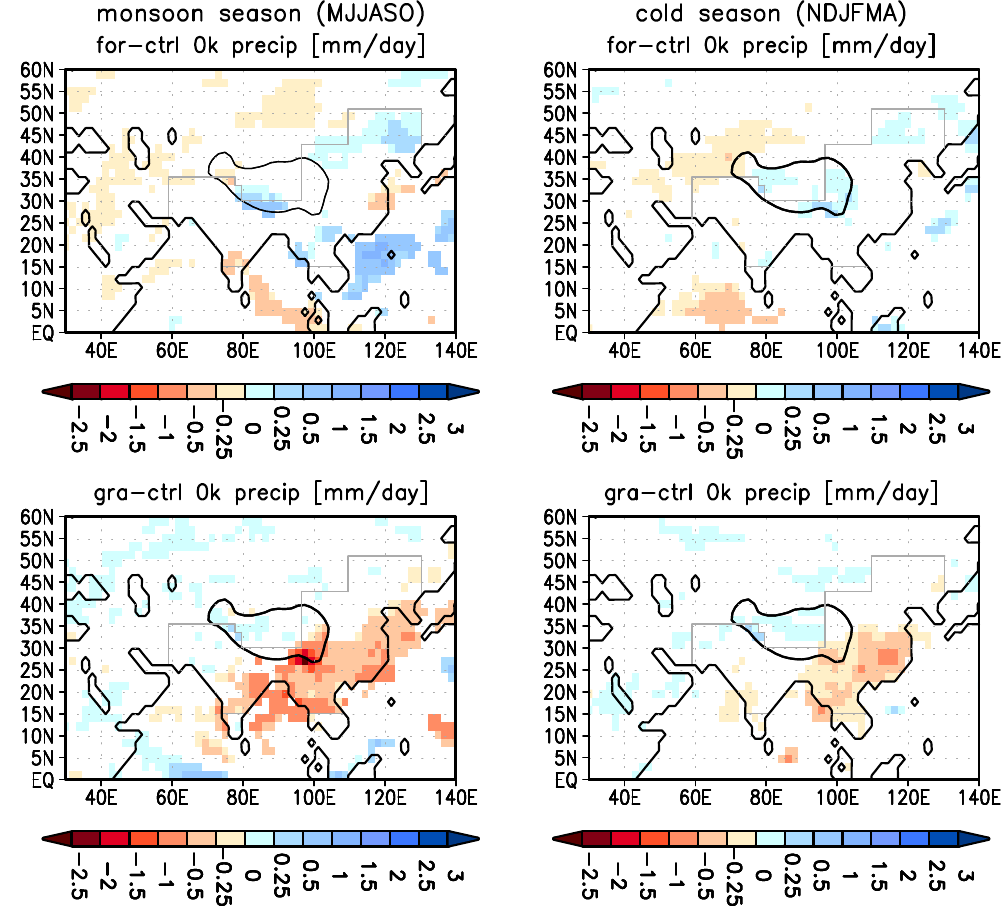
Fig. 3. Simulated precipitation change between the afforestation (for) or deforestation (gra) experiment and the control run (ctrl), averaged over the monsoon season (left panel) and the dry/cold season (right panel). The monsoon season lasts from May to October, the dry/cold season contains the month from November to April. Values are given in mmday − 1 . Only values exceeding the 95%-significance level (t-test) are